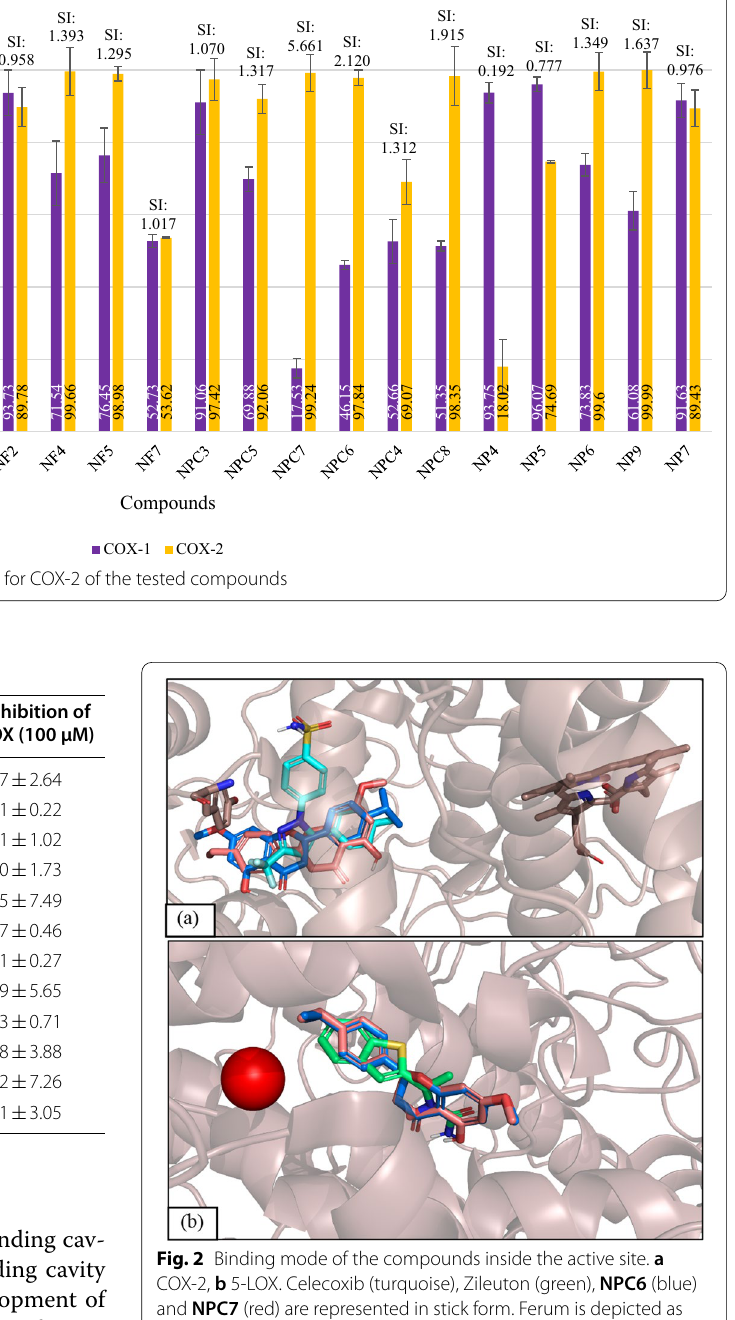
Fig. 2 Binding mode of the compounds inside the active site. a COX-2, b 5-LOX. Celecoxib (turquoise), Zileuton (green), NPC6 (blue) and NPC7 (red) are represented in stick form. Ferum is depicted as